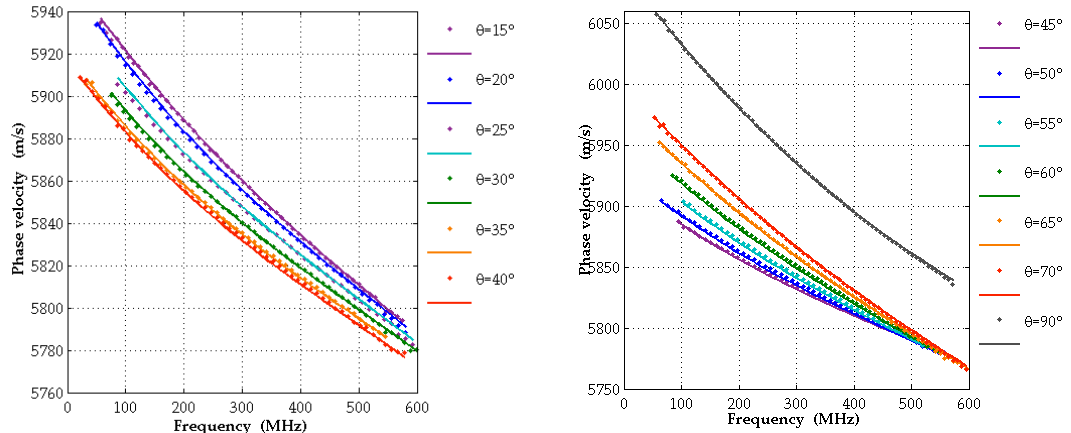
Figure 10. Experimental (dots) and theoretical (lines) dispersion curves for various SAW propagation directions for Mo/Al 0.77 Sc 0.23 N(11-20)/Al 2 O 3 (1-102). For the calculations the constants from [30] and [5] were used.